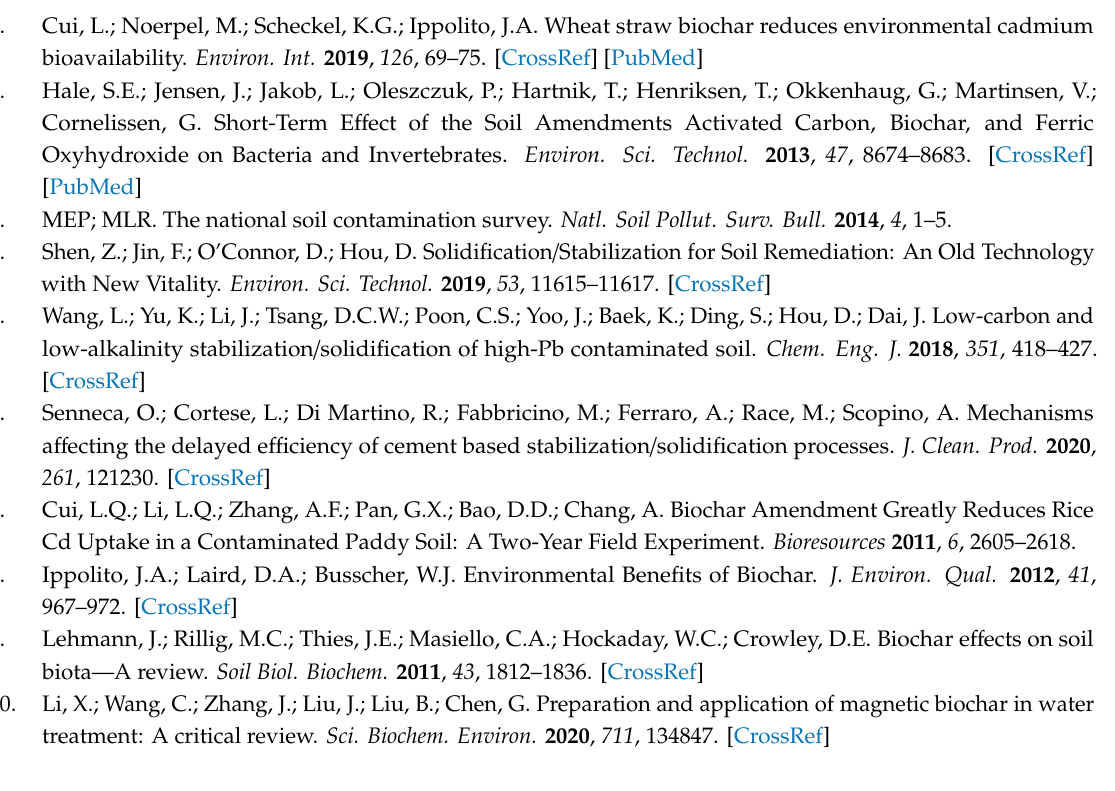
Figure S1: the schematic diagram fo the acceptor cell title, Figure S2: The e ff ect of long- and short-term, increasing biochar application rates [0(C0), 10 (C1), 20 (C2) and 40 (C3) t ha − 1 ] on water-soluble Cd and Pb with in-situ di ff erent time (A: Cd long-term; B: Cd short-term; C: Pb long-term; D: Pb short-term), Table S1: Basic paddy soil (0 to 15 cm depth) and biochar (g kg − 1 ) properties, Table S2: Bioconcentration (BCF) and translocation (TF) factors associated with biochar amend soil (biochar rates = 0(C0), 10 (C1), 20 (C2) and 40 (C3) t ha − 1